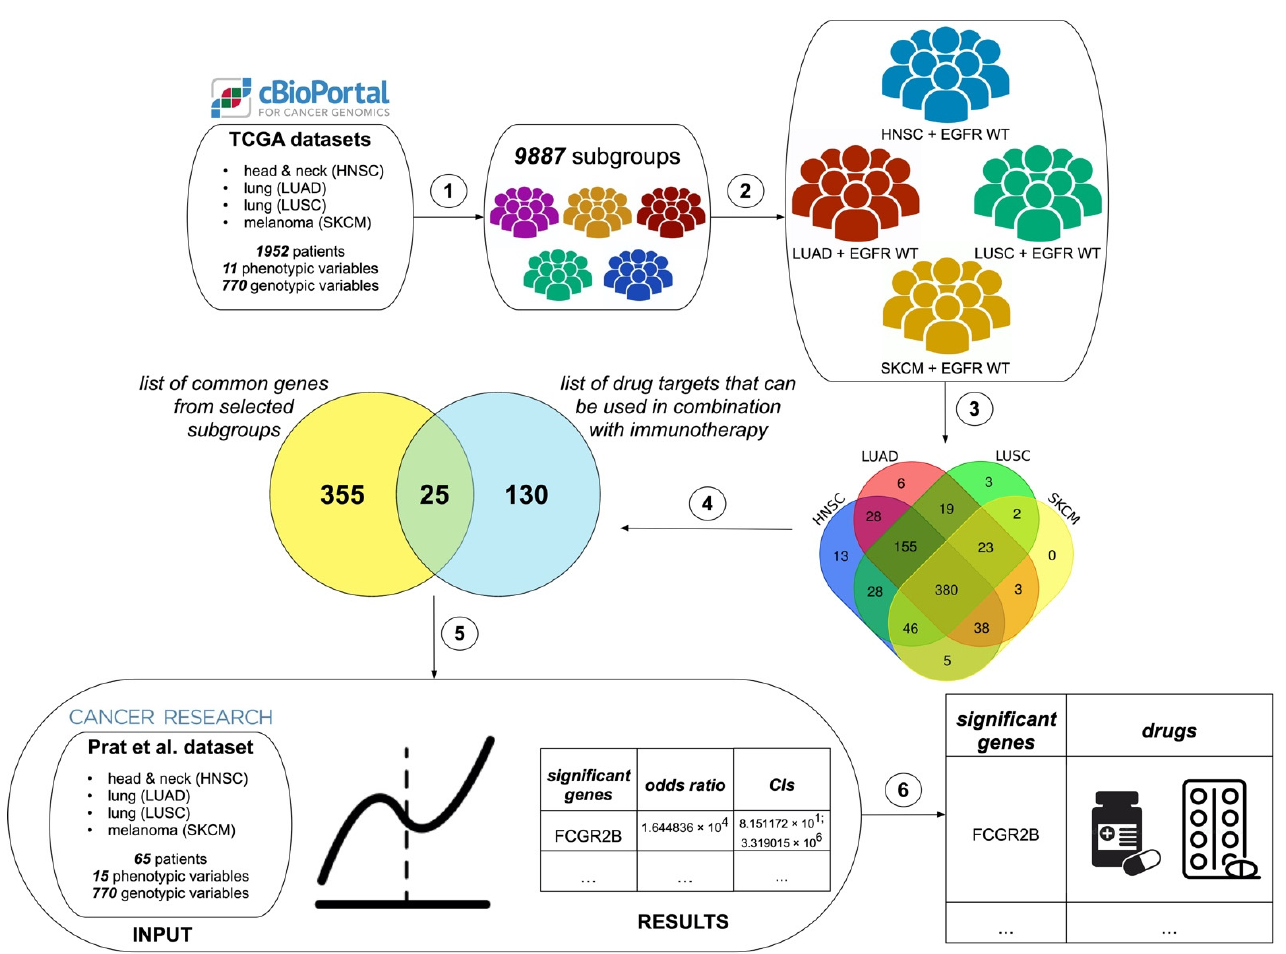
Figure 2. Informatic pipeline. ① We ran the Subgroup Discovery algorithm on the combined TCGA dataset. The algorithm output 9887 subgroups. ② We retained EGFR WT subgroups that covered at least 20% of the initial dataset. ③ For these subgroups, we determined common DE genes ( n = 380). ④ We then mapped these 380 genes to the list of 155 drug targets. Thus, we identified 25 targets that could be used in immuno-targeted combination therapies. ⑤ We determined significant drug targets that increased the likelihood of SD versus PD using the proportional odds model. ⑥ We matched significant genes to drugs that could be used in immuno-targeted combination thera- pies using the Drug Gene Interaction Database (DGIdb).